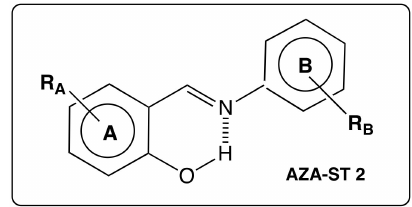
Figure 4. AZA-ST 2 bearing OH group in ortho position in ring A